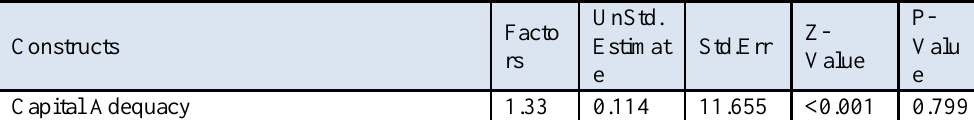
Table 5. Results of the second-order factors analysis of the modified